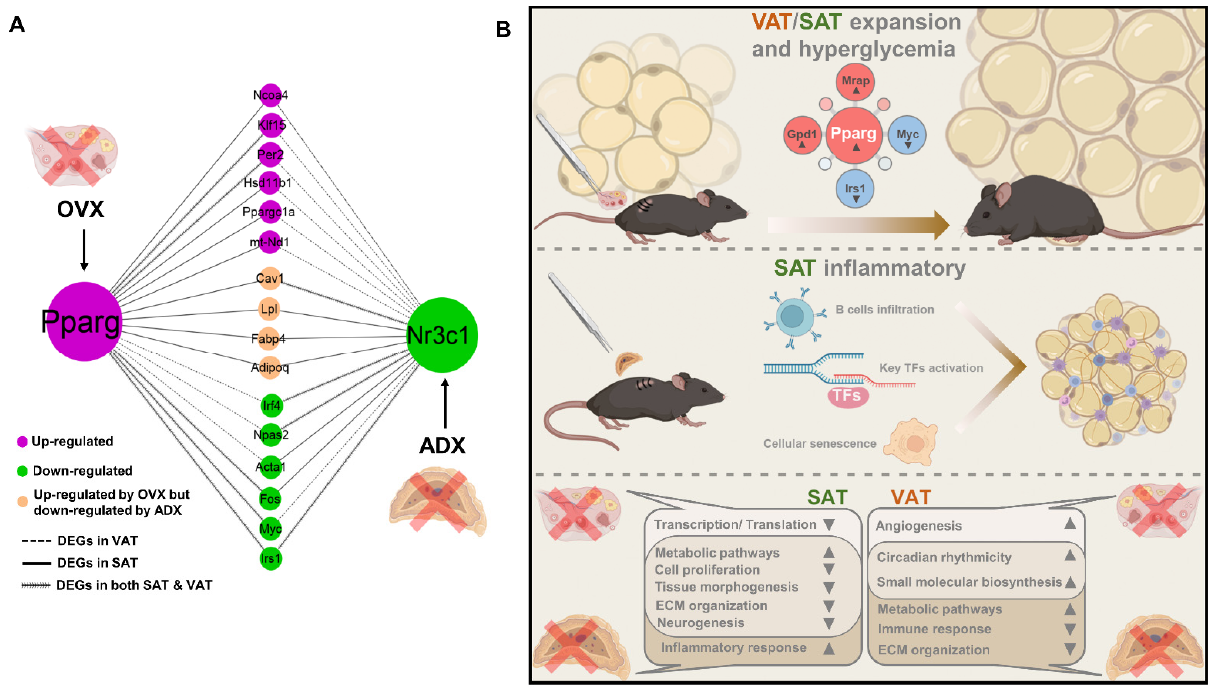
Figure 10. The distinct and common roles of ADX and OVX in regulating the heterogeneous WAT remodeling. ( A ) Crosstalk of the Pparg signaling and Nr3c1 signaling in regulating the AT remolding. ( B ) Summary of the distinct and common roles of OVX versus ADX in regulating the SAT/VAT remodeling.